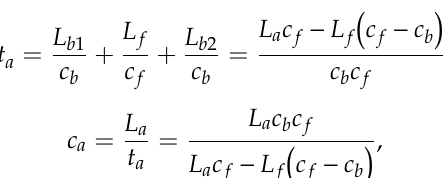
Figure 4. RC beam with circumferential debonding along the whole specimen length.